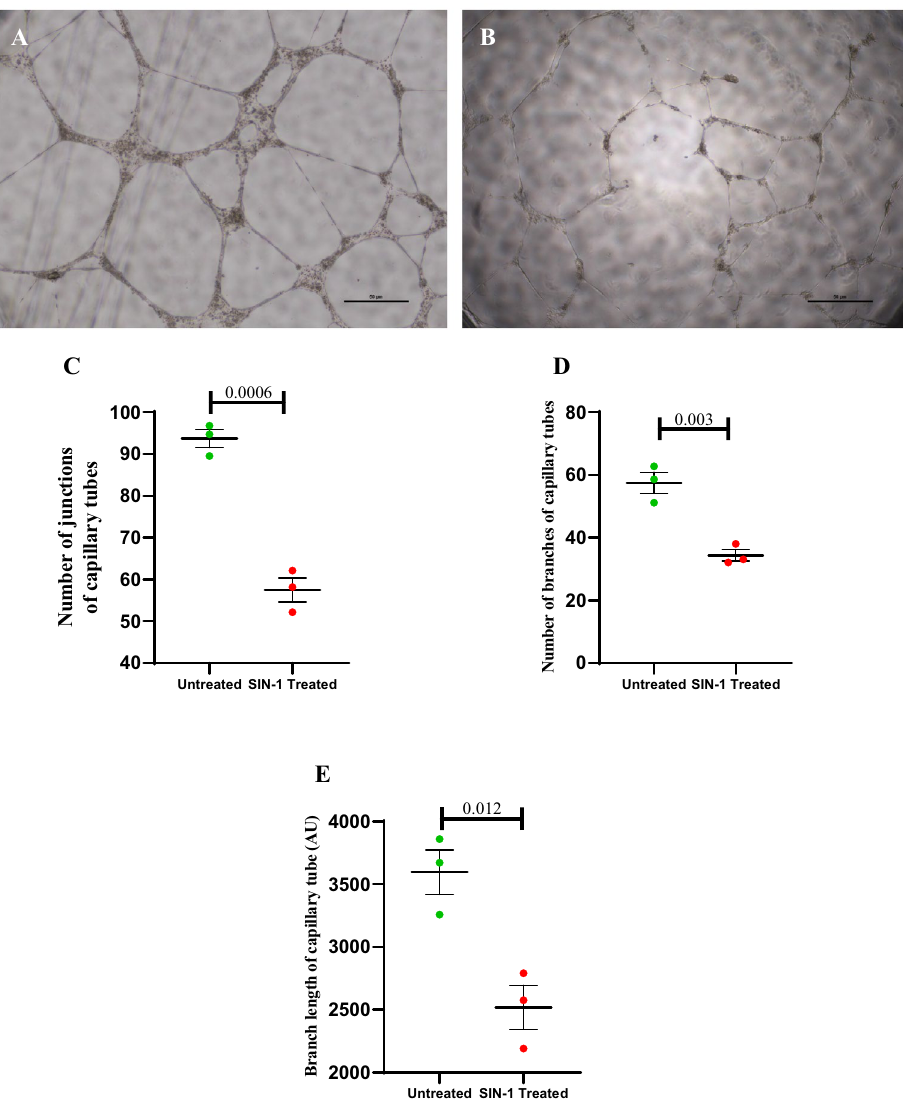
Figure 14. Effect of SIN-1 on in vitro angiogenesis by ECFCs. Image ( A ) and ( B ) shows images of capillary tube formation by ECFCs on Matrigel matrix in untreated and SIN-1 treated group respectively. Images are at 4 × magnification with 50 µm scale bar. ( C – E ) represents number of branches, number of junctions and branch length of capillary tubes formed in untreated and SIN-1 treated groups (n = 3 for each group). Student ttest was used to assess the significance difference. Data is represented as mean ± SE. Error bar represent standard error of mean; dots represent average values of the parameters obtained from experimental duplicates; p ≤ 0.05 considered statistically significant. AU: Arbitrary